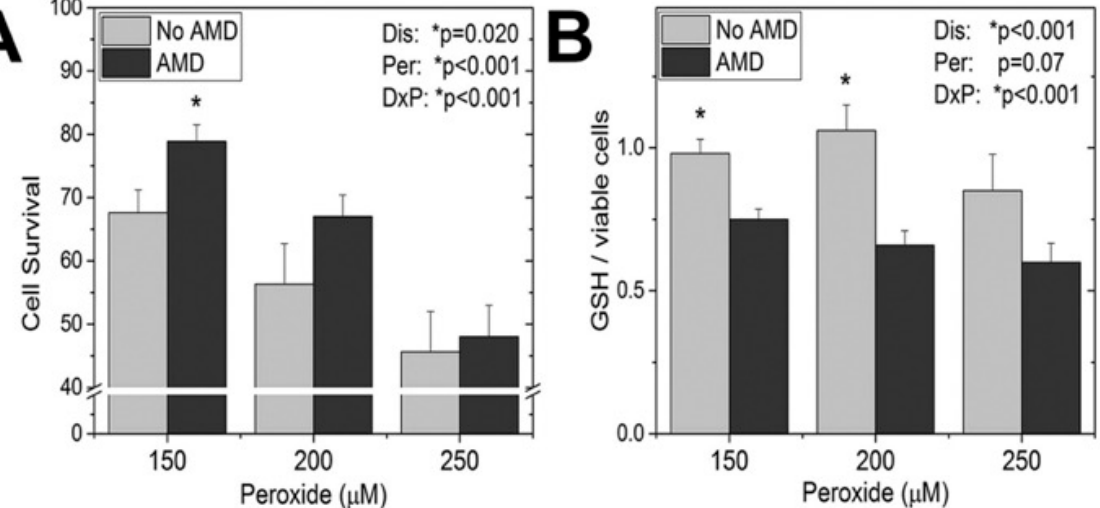
Figure 3. Effect of oxidative stress on cell survival ( A ) and GSH levels ( B ) in RPE isolated from AMD donors and age- matched controls (no AMD). Results were measured 24 h after RPEs were exposed to different doses of hydrogen peroxide. Modified from Redox Biol. 2017; 13:255–265, Ferrington et al. [21]. Copyright (2021), with permission obtained from Elsevier. * p < 0.05 as determined by 2-way ANOVA and Tukey’s post-hoc test. Results from 2-way ANOVA for disease (Dis), peroxide dose (Per), and their interaction (DxP) are shown on the graphs.